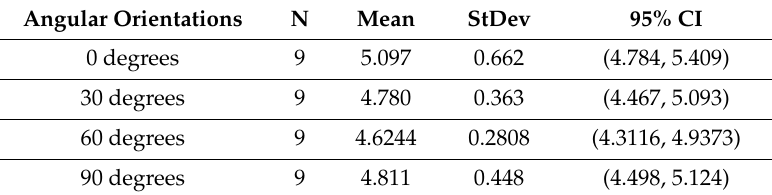
Table 22. Mean, standard deviation, confidence interval for percentage elongation as a function of angular orientations.